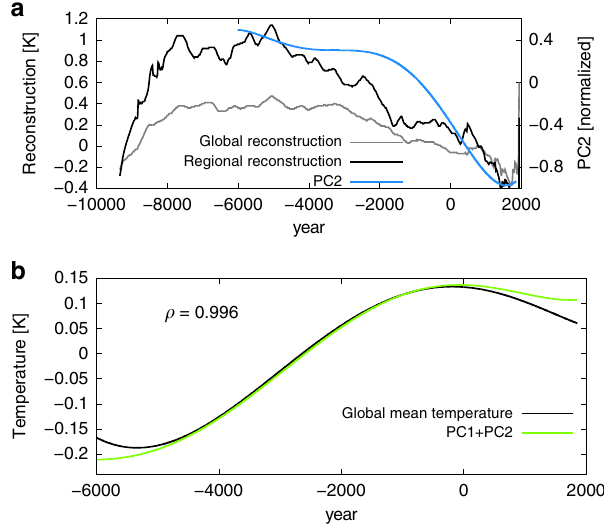
Fig. 3 Net effect of the warming and cooling mode explains the long-term temperature trends during the Holocene. a Temperature reconstructions based on Marcott et al. 2013 (gray and black curve) and the cooling mode (PC2) (blue curve). The gray curve shows the global mean temperature whereas the black curve shows a regional mean from 30 ∘ N poleward. b Low-pass fi ltered simulated annual global mean temperature anomaly (black curve) and sum of the weighted warming (PC1) and cooling (PC2) mode (green curve). The PCs have been weighted by the global means of the corresponding spatial patterns before summation. The global mean of EOF1 is about 0.238 K and of EOF2 it is about 0.066 K. ρ is the correlation coef fi cient between the two